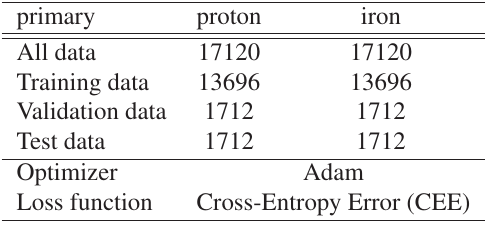
Figure 6: Machine learning model details